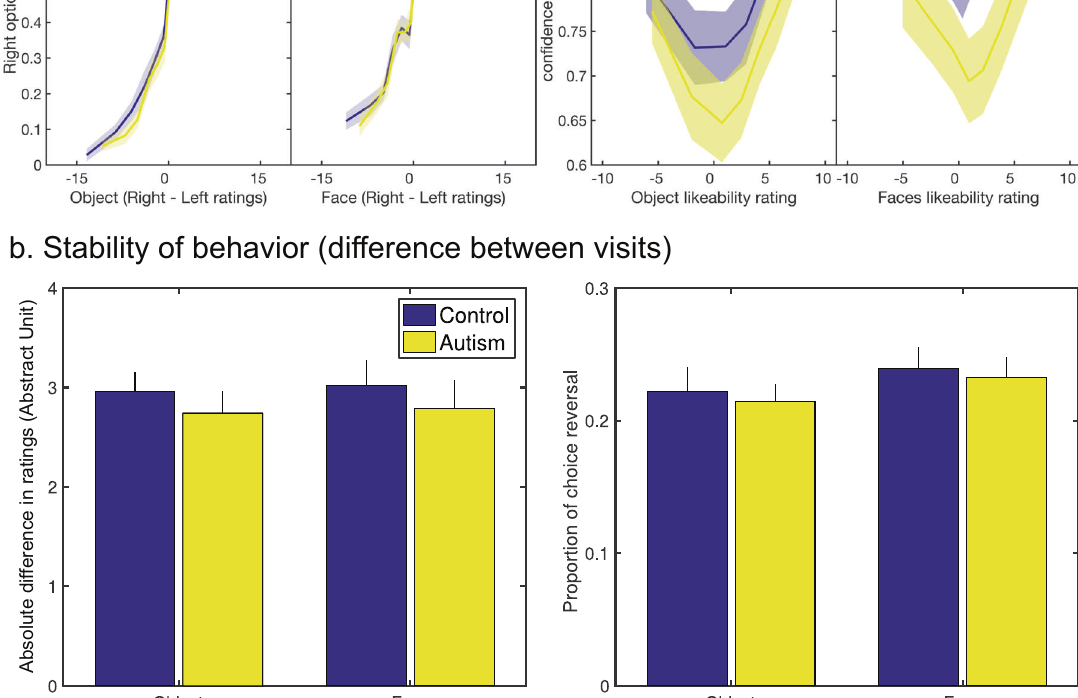
Fig. 3 Relations between likeability ratings and other behavioral variables. a Binary choices. Probability to choose the right object/face over the left one as a function of the difference between likeability ratings (obtained in the fi rst visit). b Stability of behavior. The absolute difference between visits for likeability ratings (left panel) and proportion of choice reversal for binary choices (right panel). c Con fi dence ratings as a function of likeability ratings (obtained in the second visit). Shaded areas and error bars represent inter-participant s.e.m. In every panel, data were plotted on the left for objects and on the right for faces, in blue for control participants and yellow for autistic